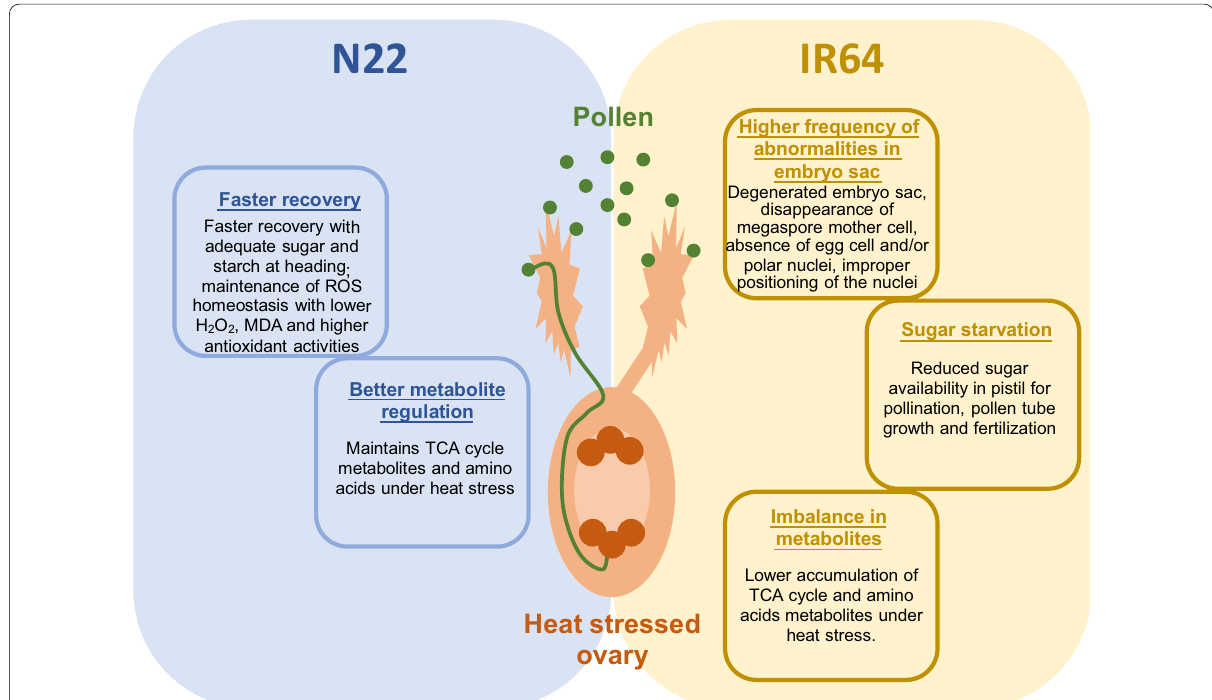
Fig. 11 Mechanisms leading to heat sensitivity (reduction in spikelet fertility under heat stress) in IR64 pistil and or processes that allow functional pistil in N22 exposed to heat stress during